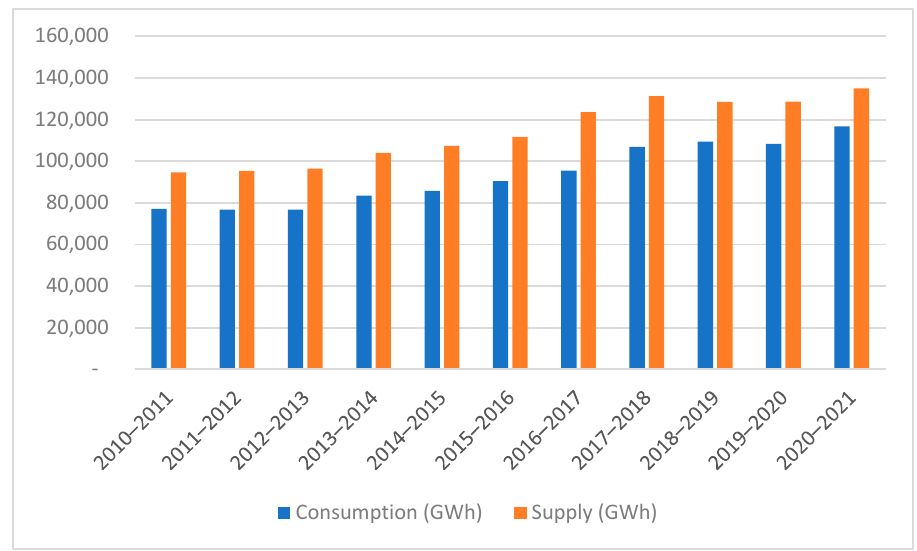
Figure 3. Supply and consumption of electricity units in Pakistan (GWh).